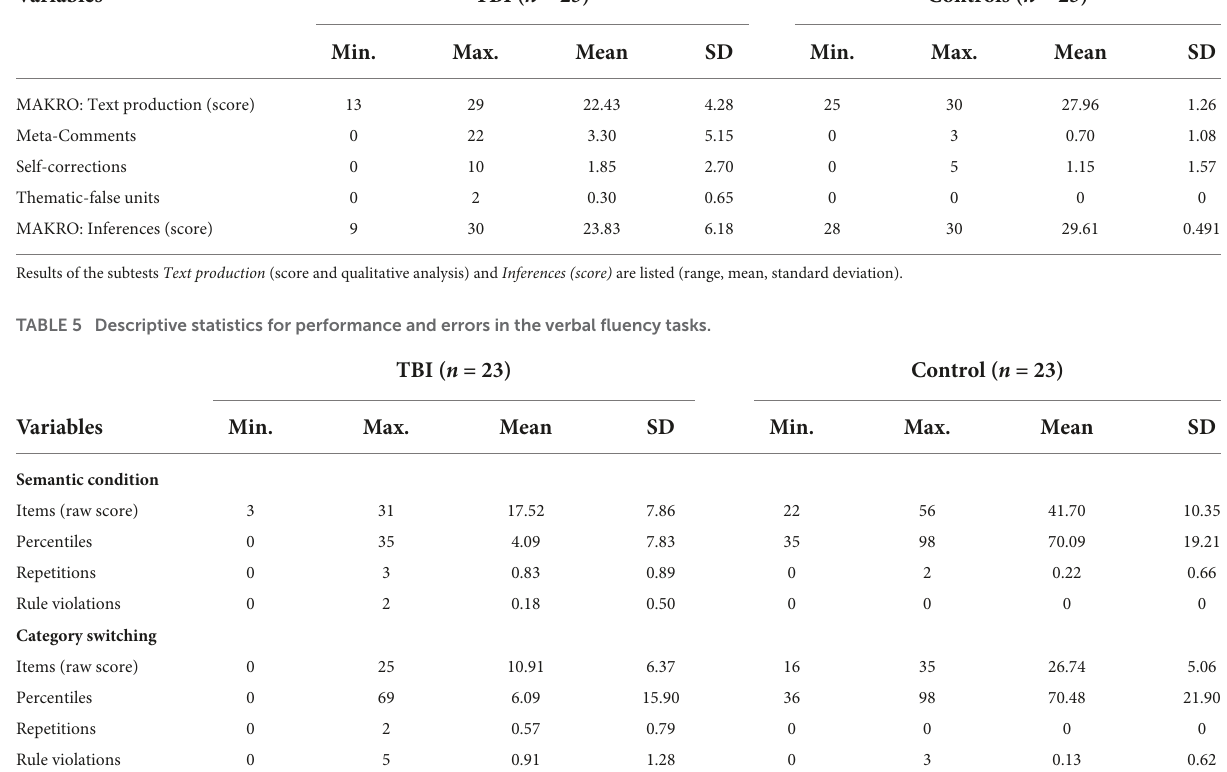
TABLE 4 Overall results in the MAKRO subtests.